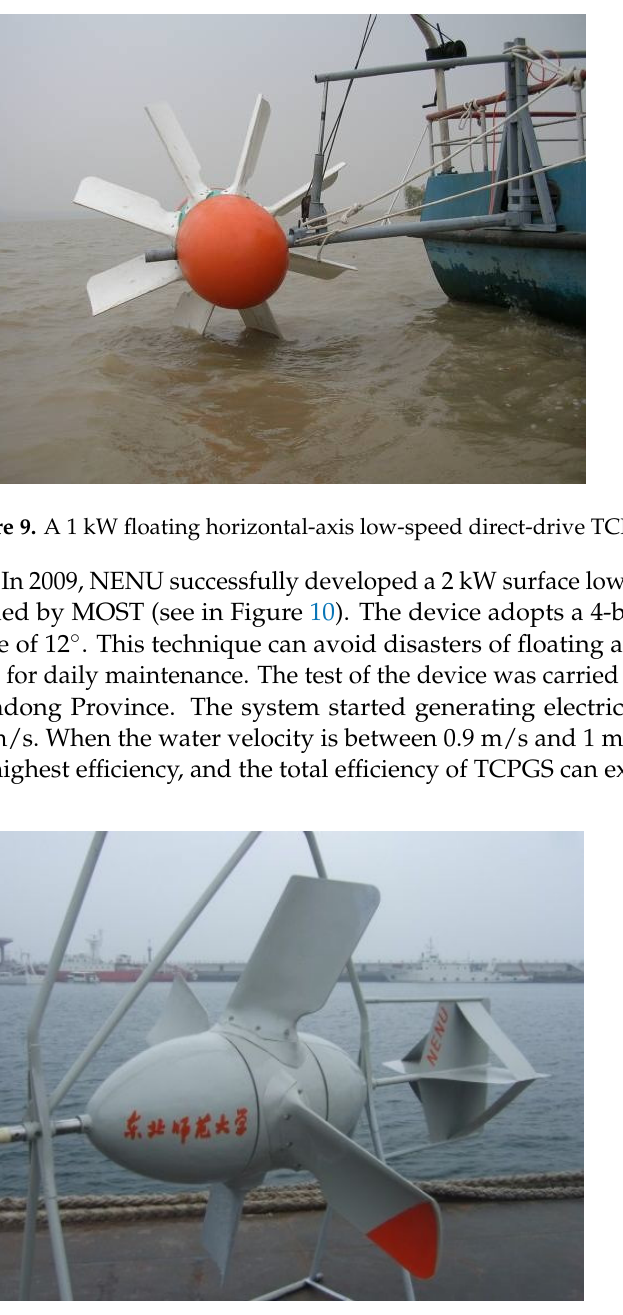
Figure 10. A 2 kW surface low-speed direct-driven TCPGS. Reproduced from [26].